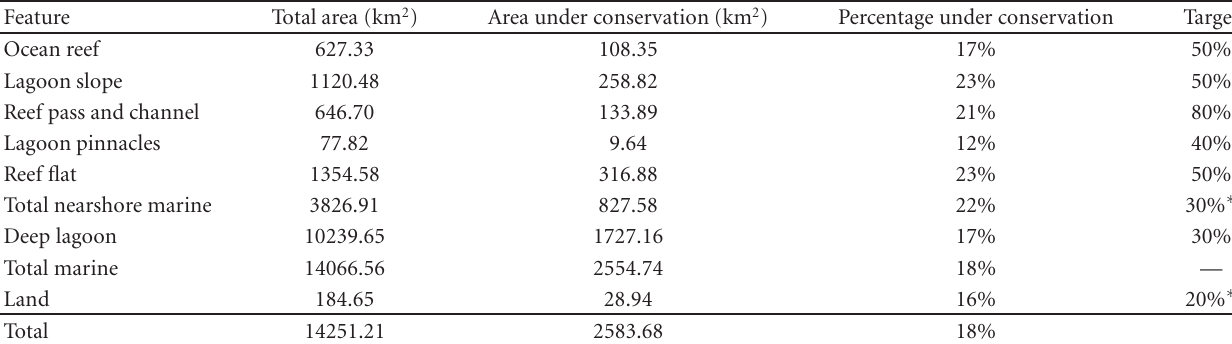
Table 3: Gap assessment: current area under conservation against the goals for coarse-scale conservation